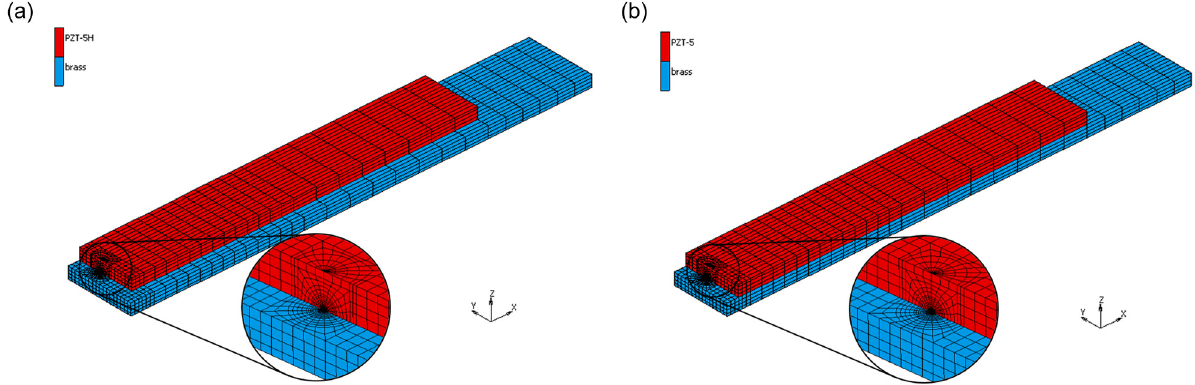
Figure 4: The FE models used to obtain the displacements and the electric potentials for front - line at d = 3 mm: ( a ) Model - 1 and ( b ) Model - 2.